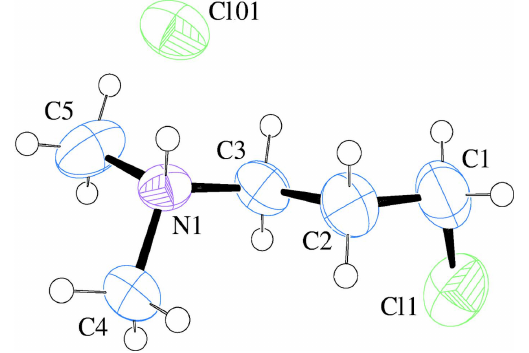
Figure 1 Displacement ellipsoid plot (50% level) of the formula unit of the title compound with labels for non-H atoms. H atoms are drawn as circles of arbitrary radii.